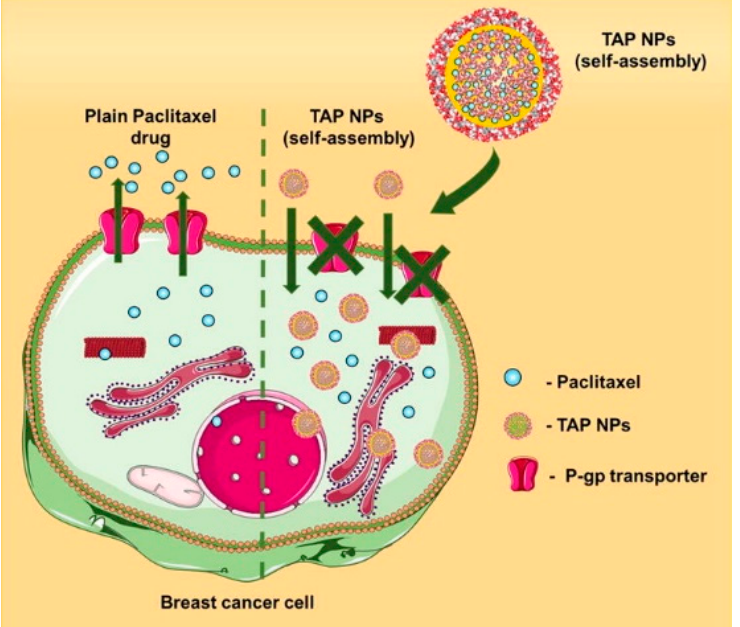
Figure 5. Diagrammatic illustration of the self-assembled tannic acid nanocarriers loaded with paclitaxel with reduced P-glycoproteins efflux pump activity. Reprinted with permission from ref. [123] . Copyright 2019 Elsevier, under the license number 5139510913463.